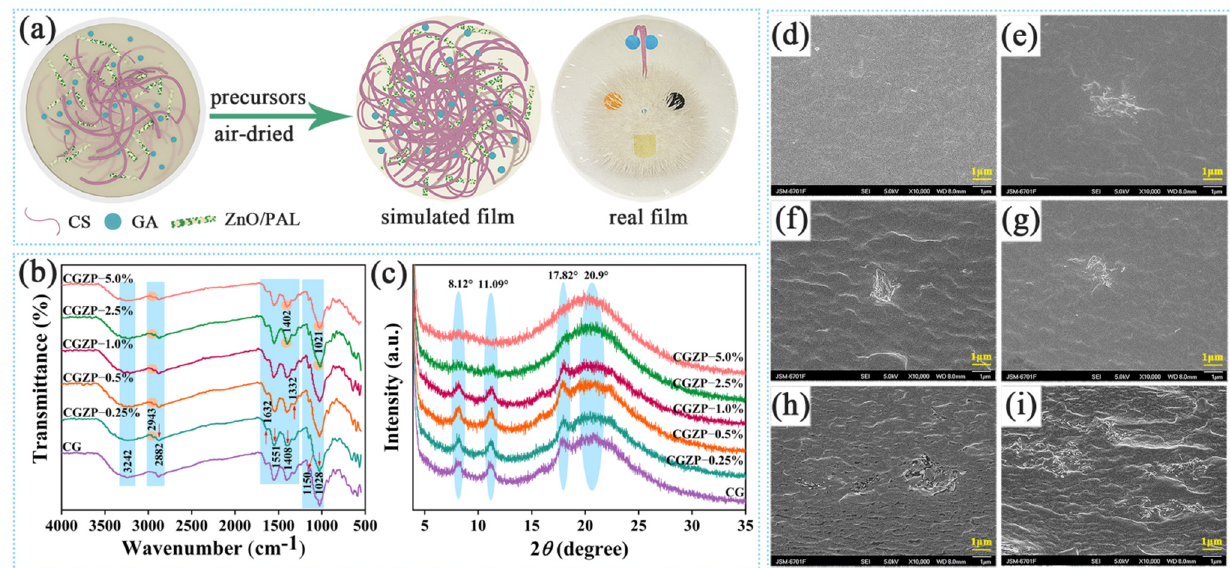
Figure 1 . The simulation process of films (the digital photo of the real film was taken by overlaying the film on a photo of cartoon character we drew by ourselves) ( a ), ATR-FTIR spectra of CG and CGZP films ( b ), XRD patterns of CG and CGZP films ( c ), SEM micrograph of the cross-section of CG ( d ), CGZP − 0.25% ( e ), CGZP − 0.5% ( f ), CGZP − 1.0% ( g ), CGZP − 2.5% ( h ), and CGZP − 5.0% ( i ) films with a magnification of 10,000.